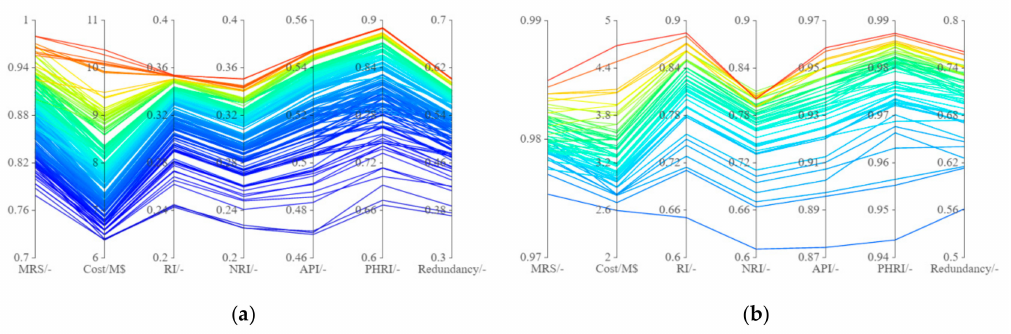
Figure 5. New PCPs for the HAN and BIN design problems. ( a ) HAN; ( b )